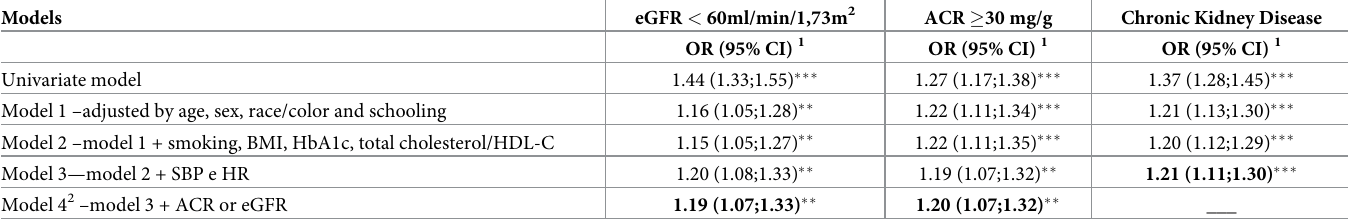
Table 3. Logistic regression models of the association between pulse wave velocity (m/s) and renal function markers in adults without CVD and free of hypertension and diabetes, participants in the ELSA-Brasil cohort baseline, 2008–2010.